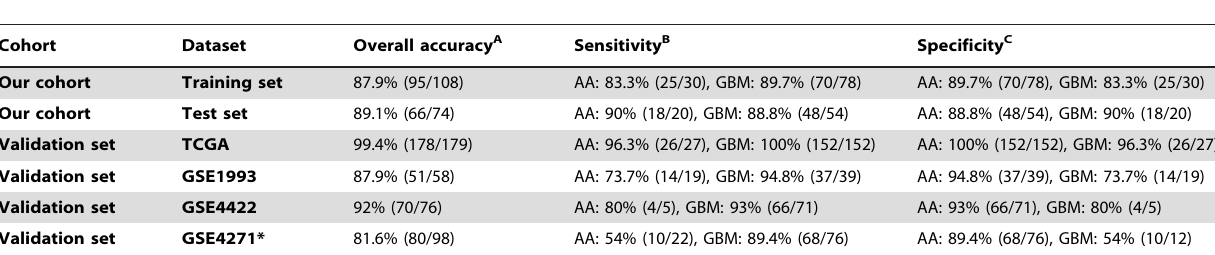
Table 2. The diagnostic accuracy, sensitivity and specificity of 16-gene signature to discriminate AA and GBM in training set, test set and three independent cohorts (TCGA, GSE1993, GSE4422) of patient